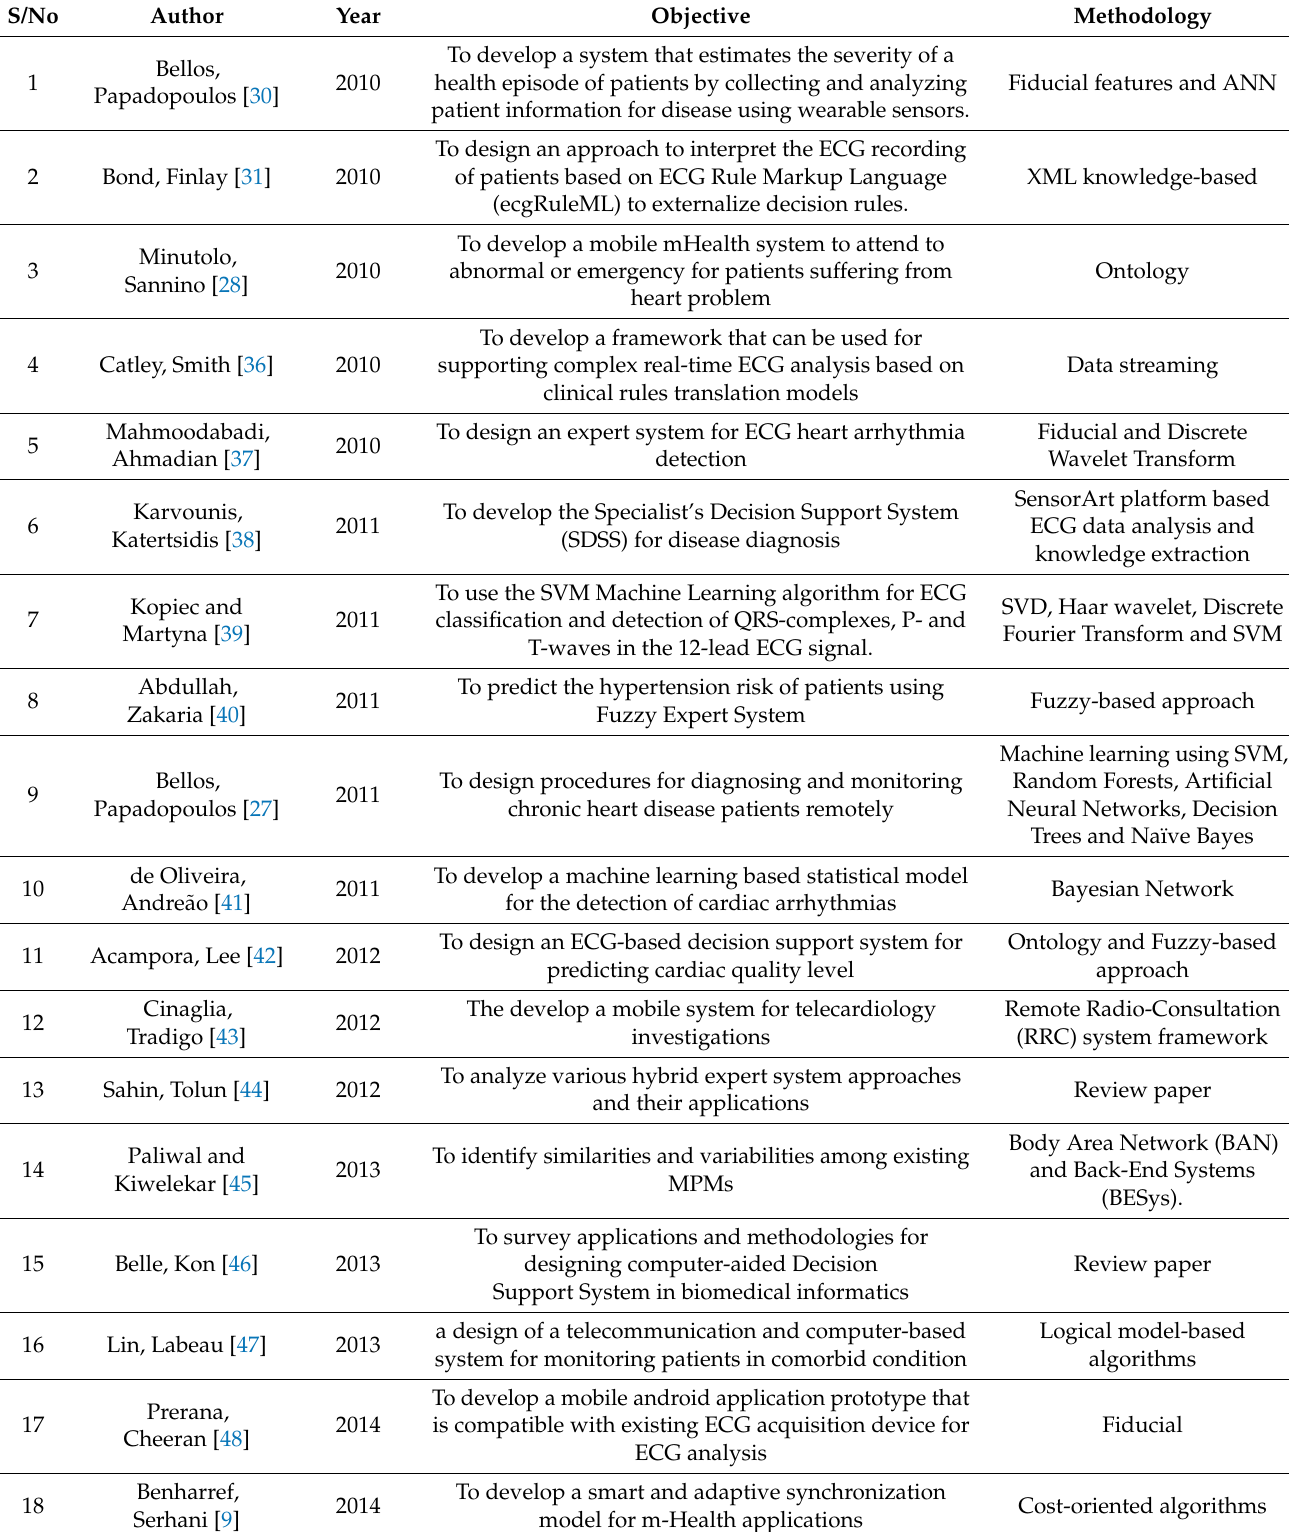
Table 1. Summary of the studies on ES and DSS for electrocardiogram interpretation and